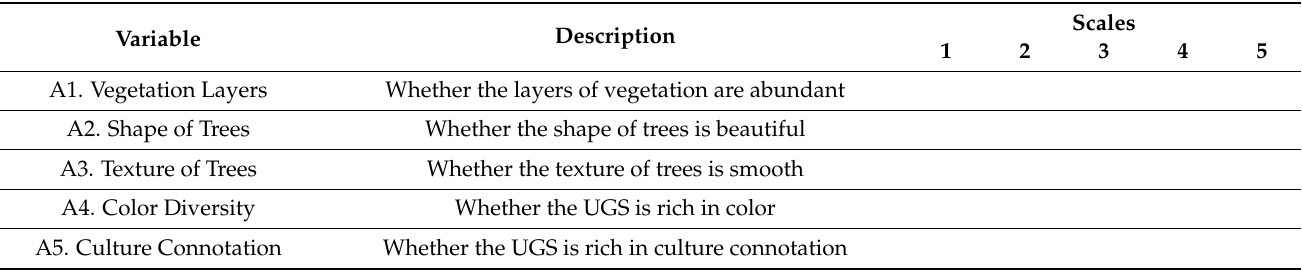
Table A2. Short version revised scale for perceived plant